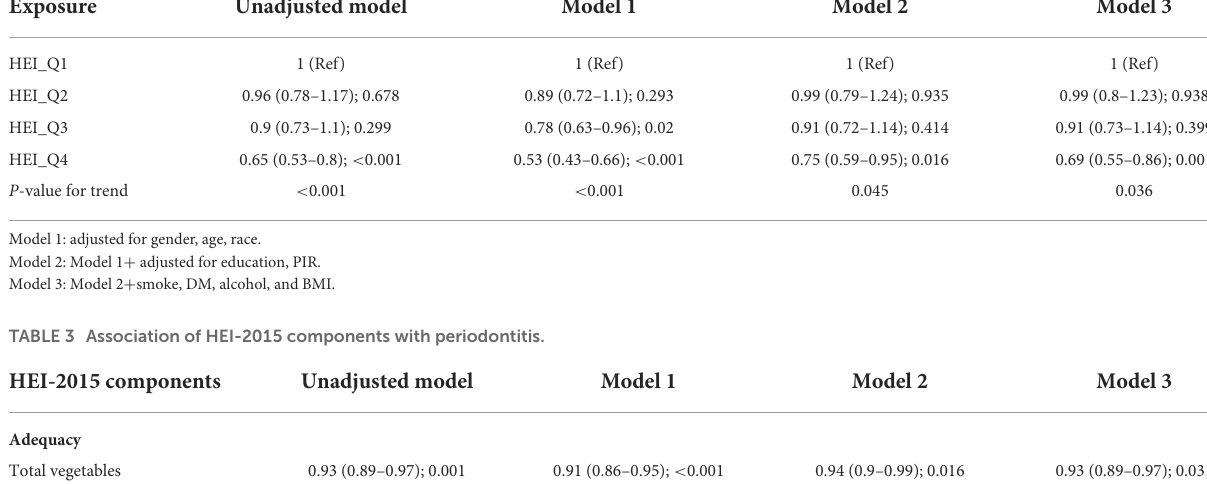
TABLE 2 Association of HEI-2015 with periodontitis.